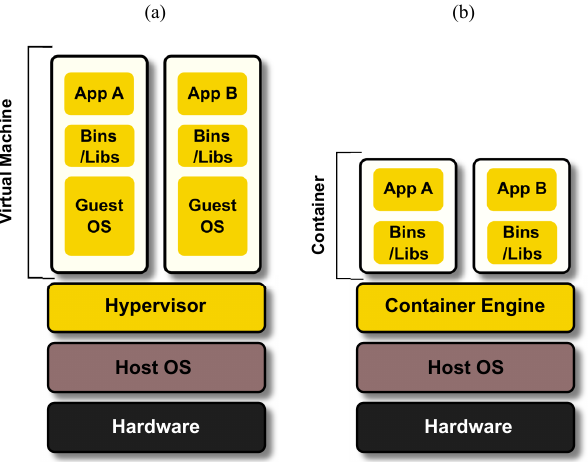
Figure 5. A comparison between Virtual Machine layers ( a ), Container Layers ( b